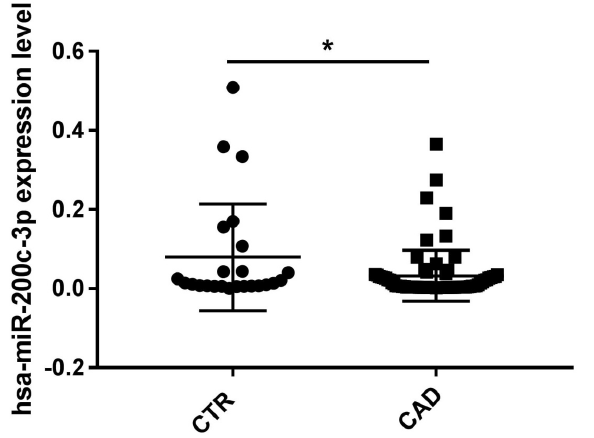
Figure 5. Expression level of hsa-miR-200c-3p in the comparison CAD vs CTR patients. Mann–Whit-